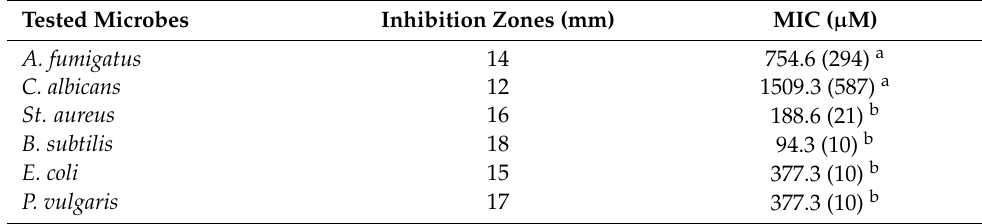
Table 3. Inhibition zones (mm) and MIC values ( µ M) against different microbes. Tested